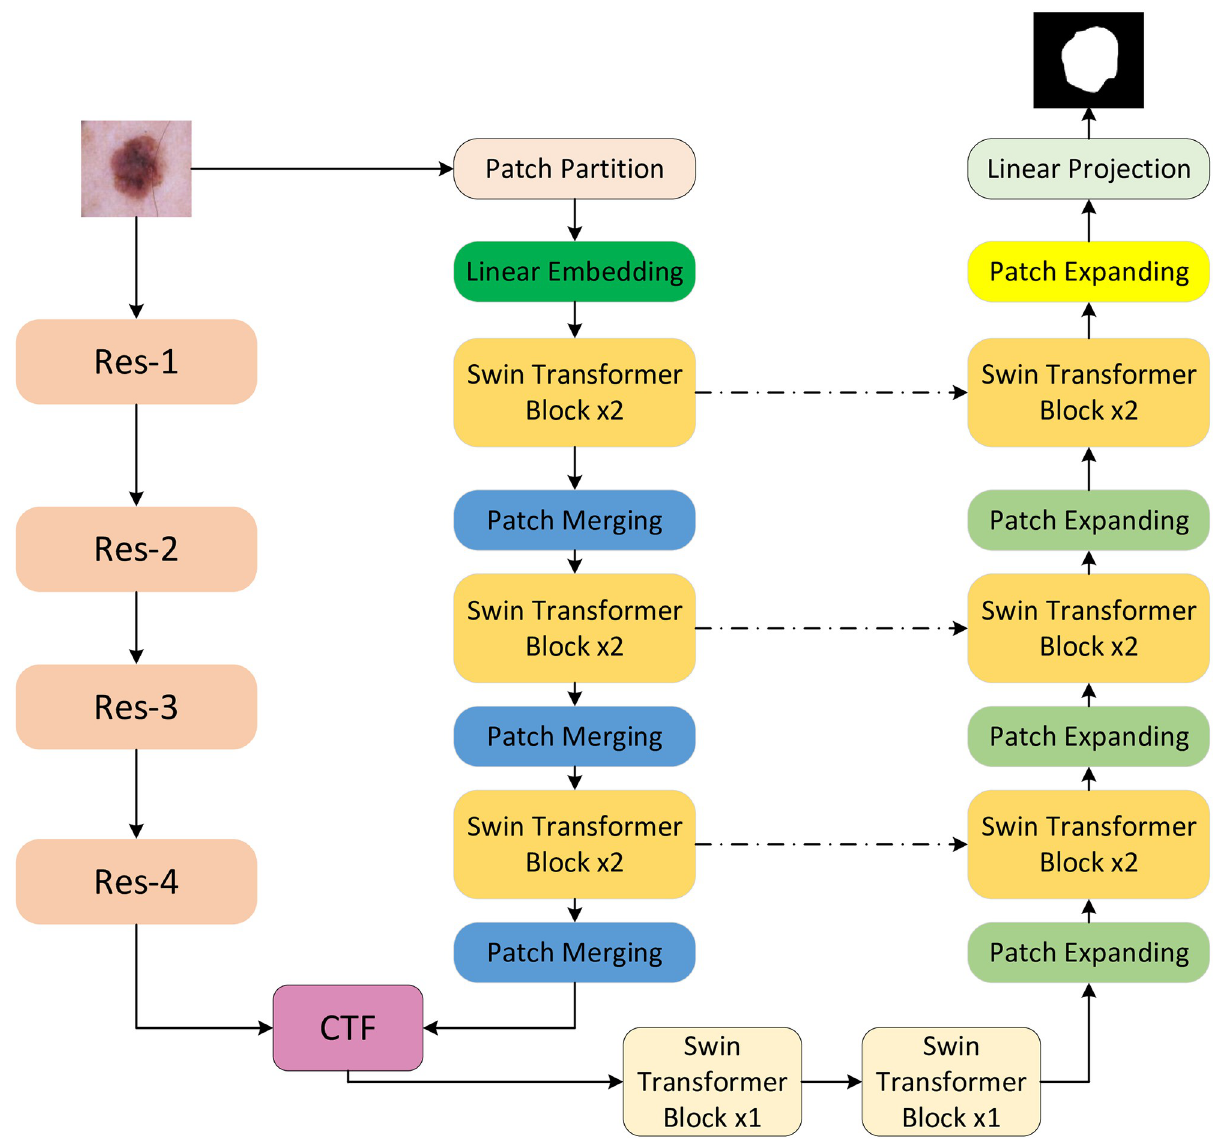
Fig 1. The overall architecture of TC-Net. The image to be processed and input it to the dual coding channel at the same time, then fuse at the bottom of the coding to decode and output the split image.